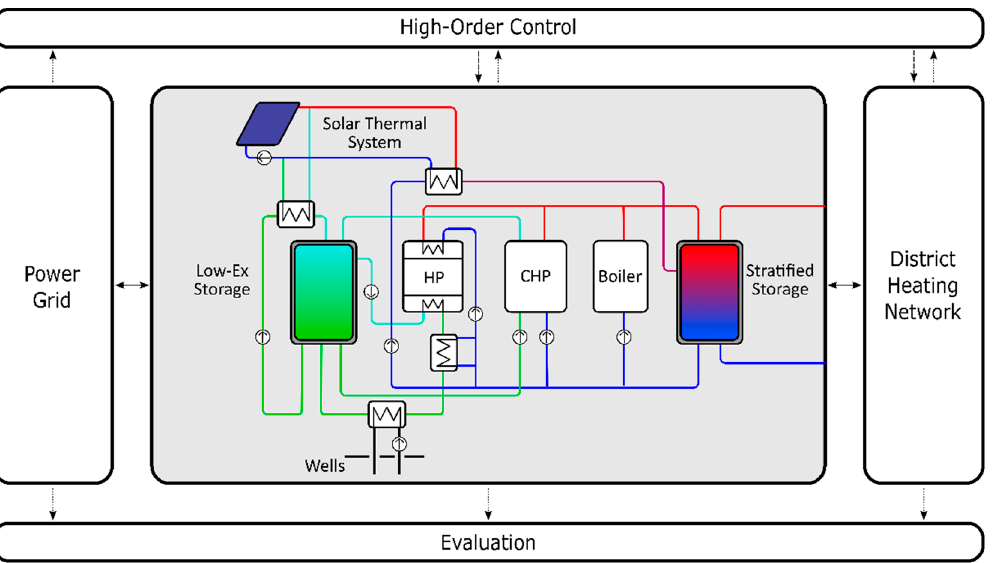
Figure 8. Structure of the simulation model of the DHN in Dollnstein [29]. Solid arrows represent the exchange of physical quantities (i.e., heat and electricity), dotted arrows indicate an exchange of information (e.g., measurement data), dashed arrows represent control signals. Table 2. Control strategies and corresponding flow and return temperatures of the DHN in Dollnstein during German winter and summer